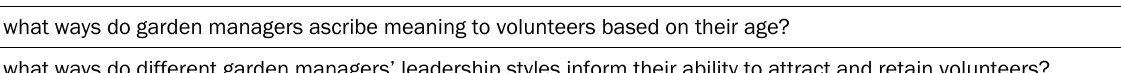
Table 3. Final Research Questions Who participates in the community garden?